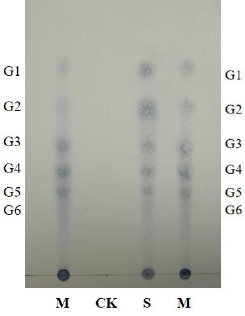
Figure 2. TLC analysis of n Ta AA9A reaction products using PASC as a substrate. n Ta AA9A reaction products were formed following incubation of 0.5% PASC with n Ta AA9A in 10 mM HOAc–NH 4 OAc (pH 5.0) and 1 mM ascorbate at 50 °C for 48 h. Lane M, standard cello-oligosaccharides (G1–G6); Lane S, n Ta AA9A reaction products; Lane CK, control sample analyzed as above, except that no n Ta AA9A was added.